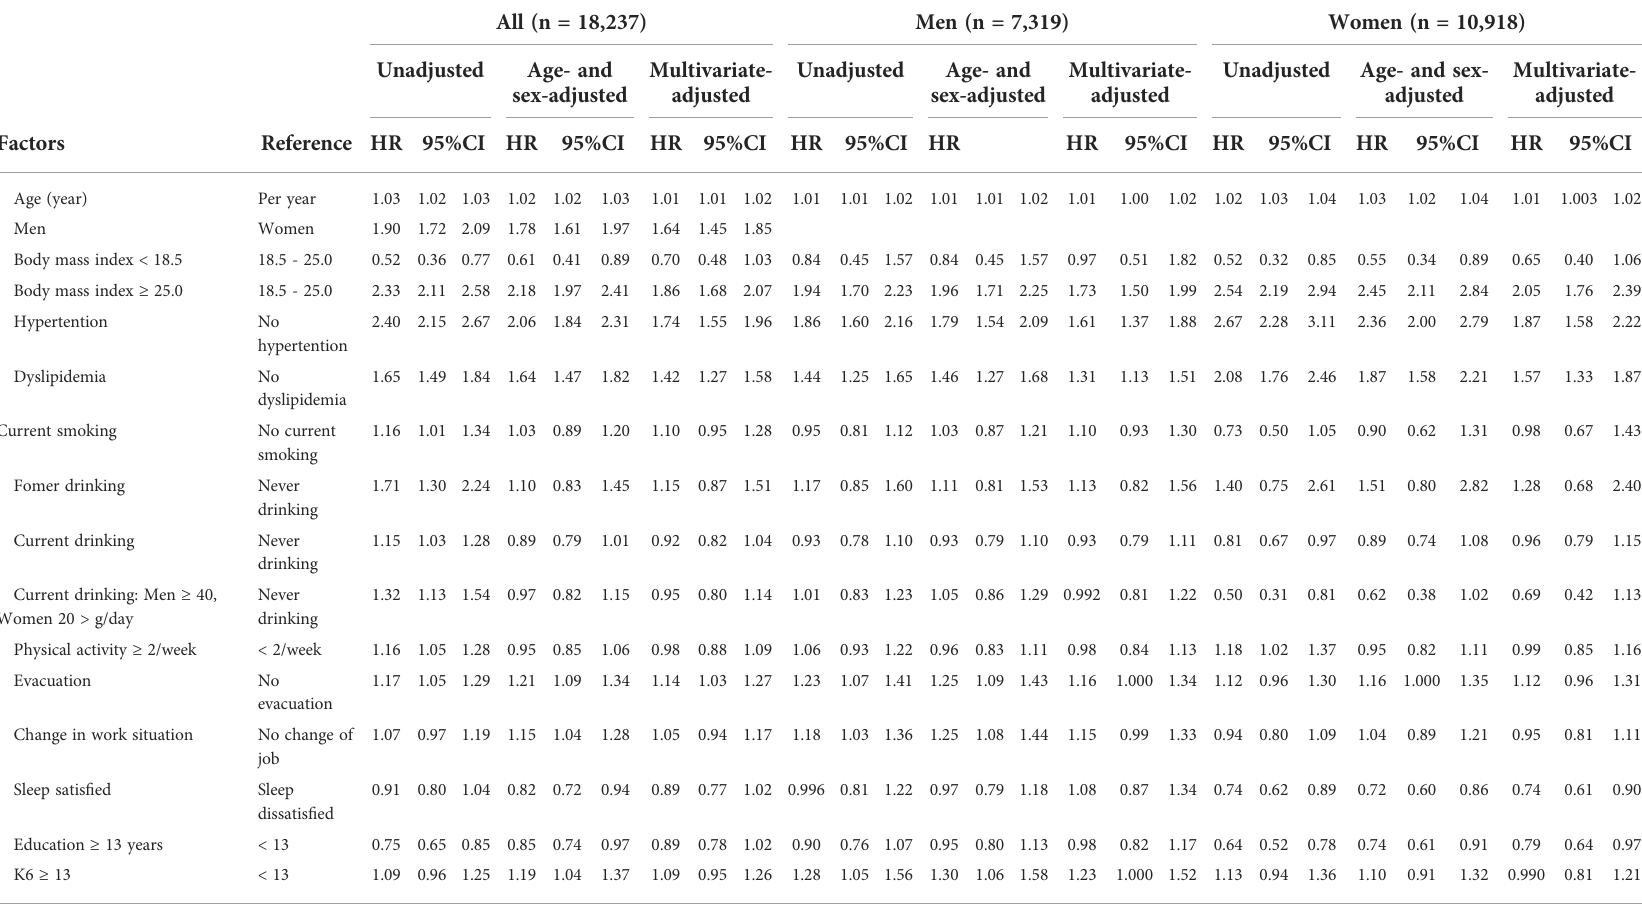
TABLE 2 Factors associated with new-onset diabetes